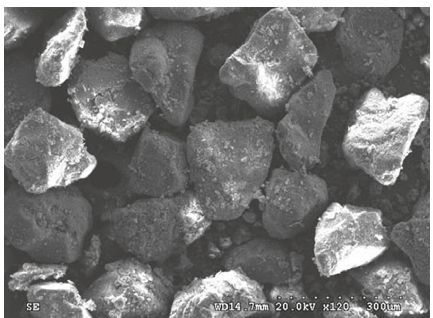
Figure 3: Scanning electron microscopic images of ordinary sand.